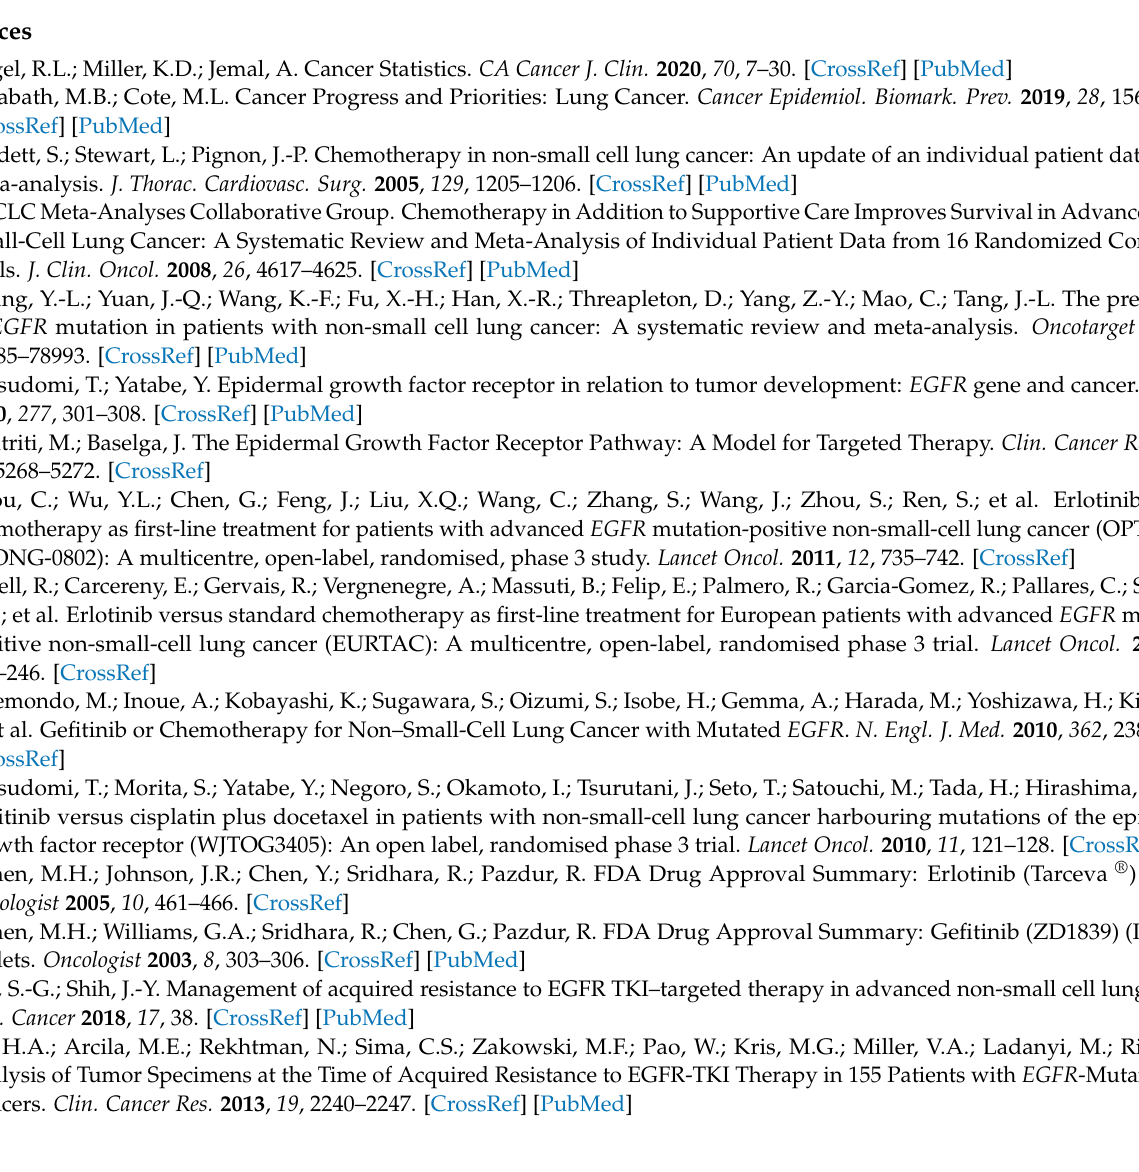
cells, Figure S2: Representative images of flow cytometry, Figure S3: Effects of ESB on apoptosis in- duction and STAT3 activity in EGFR TKI-sensitive PC9 cell line, Figure S4: Concentration-dependent suppression of STAT3 by ESB in EGFR TKI-resistant human NSCLC cell